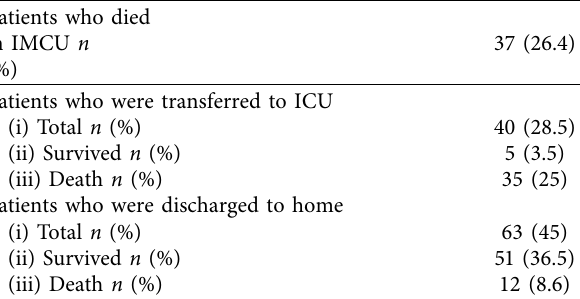
Table 5: Percentage of death and survival in all patients. Patients who died